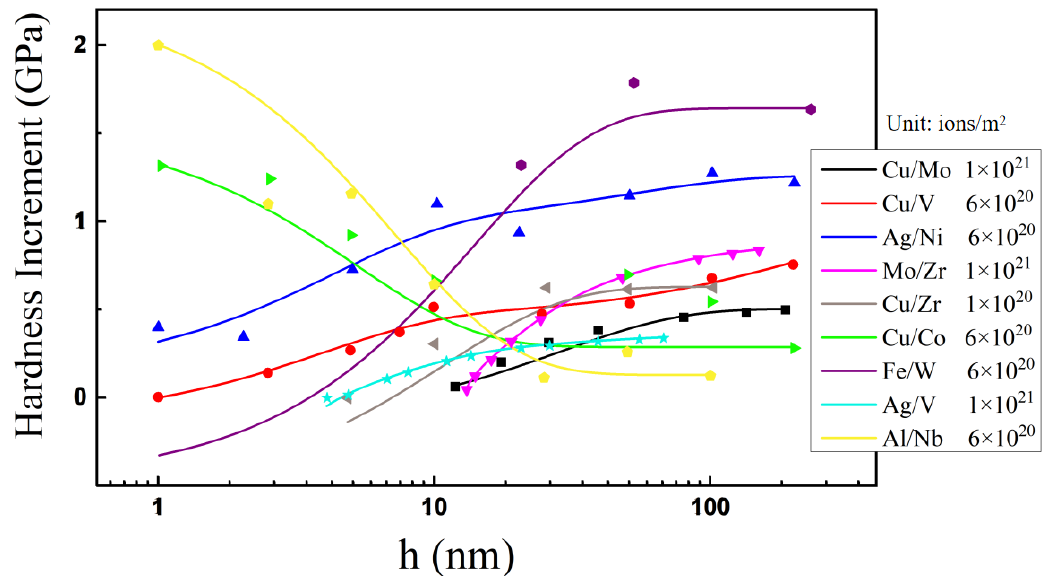
Figure 13. The relationship between the layer thickness of Cu/Mo [129], Cu/V [5], Cu/Zr [84], Ag/Ni [110], Ag/V [130], Mo/Zr [92], Fe/W [3], Cu/Co [76], and Al/Nb [57] multilayer films and the hardness increment after irradiation with different sources, as shown in Table 5.